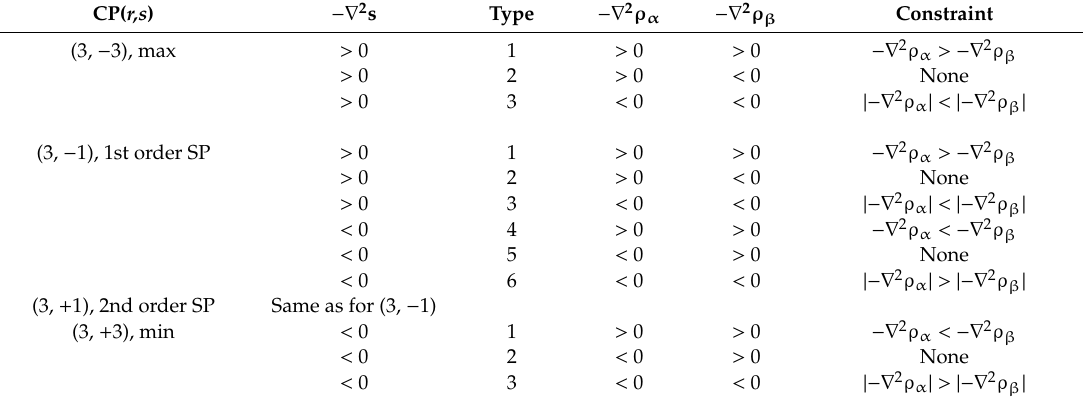
Table 1. Classification of all possible non–degenerate spin density critical points CPs( r , s ) in terms of their rank r , signature s and possible types, depending on −∇ 2 ρ α and −∇ 2 ρ β